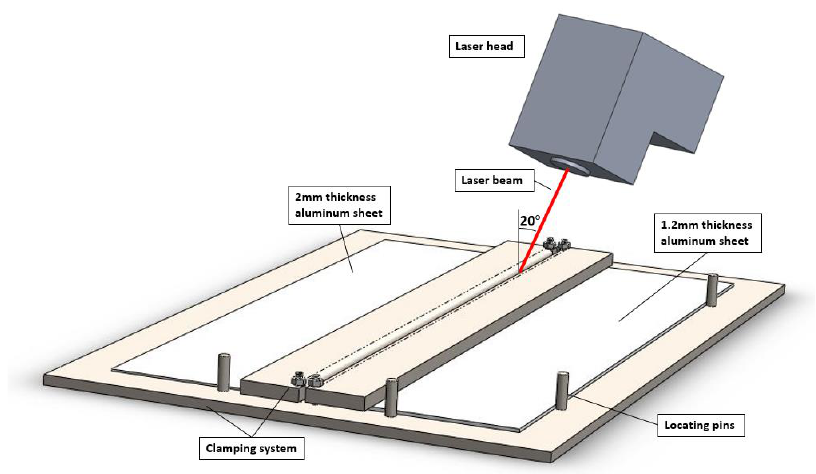
Figure 1. Mechanical fixture for welding the aluminum sheet coupons and laser welding.